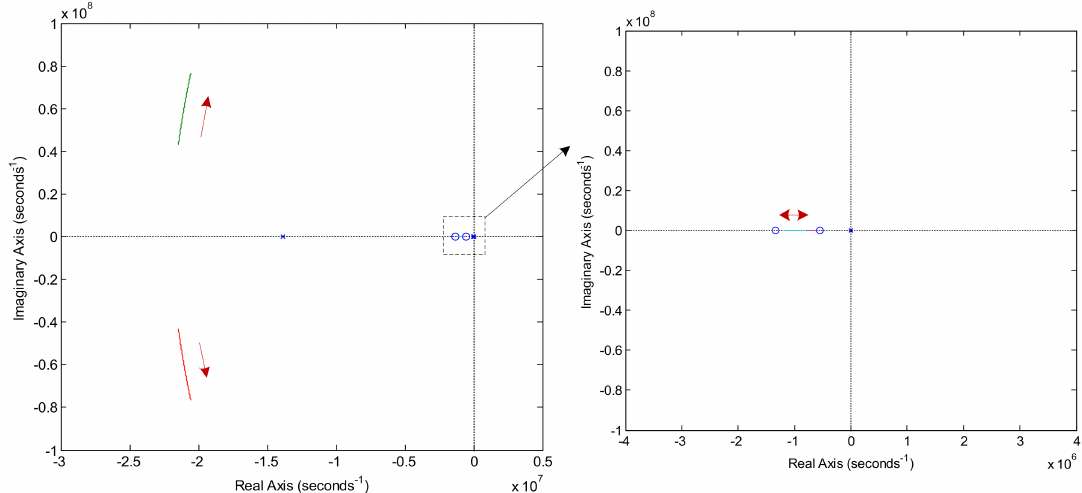
Figure 21. The root locus of the power